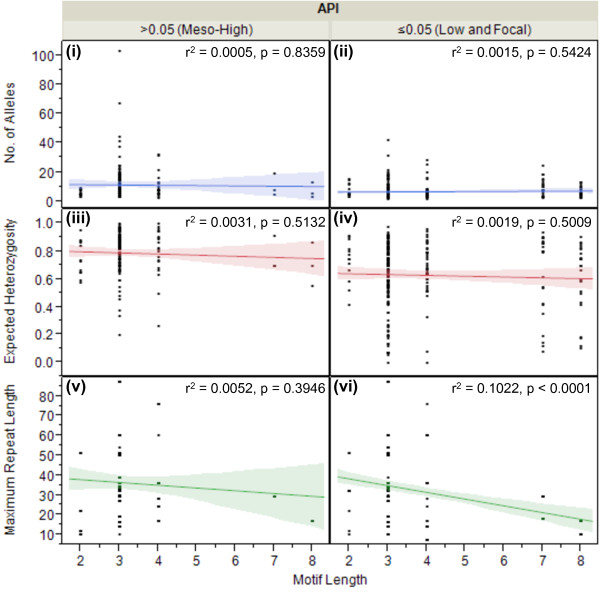
Motif length as a function of MS diversity. For all MS markers combined, the box plots compare the mean number (no) of alleles per locus (y-axis, blue), expected heterozygosity (He) (y-axis, red) and maximum repeat length (y-axis, green) across all motif lengths (x1°-axis), stratified API (x2°-axis). There were no significant correlations between motif length and the mean no of alleles per locus (panels i, ii) or mean He(panels iii, iv) in either API stratum. However, in the ≤0.05 API stratum there was a significant negative correlation between motif length and mean maximum repeat length (panel vi) (p <0.0001, ANOVA, bivariate fit). This correlation exists only as a trend for the >0.05 API stratum (panel v) (p = 0.349, ANOVA, bivariate fit).